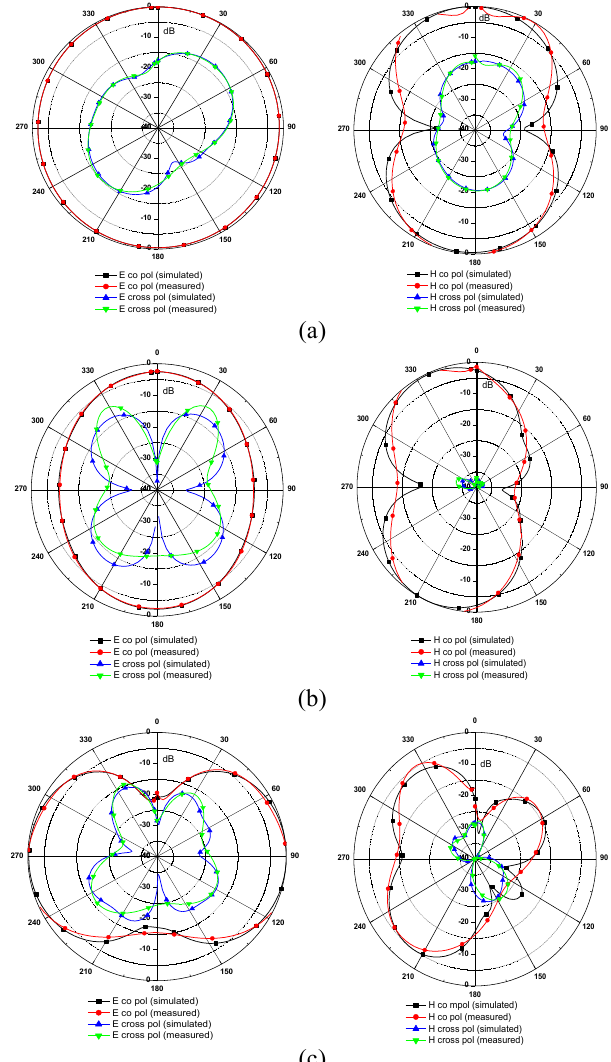
Figure 10: Radiation patterns at various frequencies of octagonal ring shape wideband antenna (a) 2.85 GHz (b) 5.14 GHz and (c) 7.61